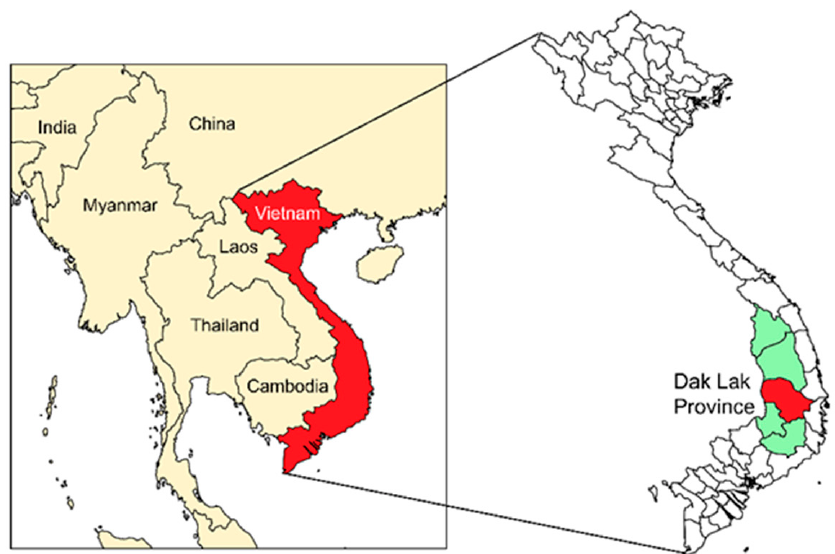
Figure 1. Map of the blood collection sites. Blood samples were collected from P. falciparum -infected patients who resided in Dak Lak Province of the Central Highlands, Vietnam in 2019. The Central Highlands region and Dak Lak Province are colored with green and red, respectively.